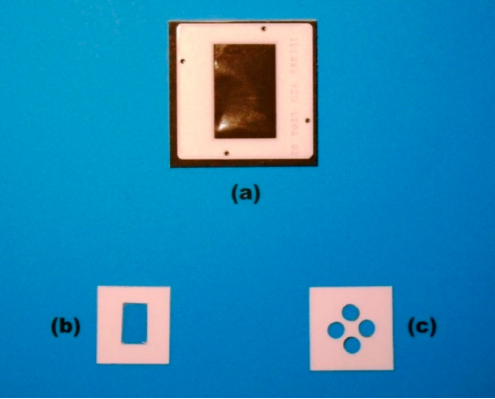
Figure 4. Three di ff erent PSP film badge